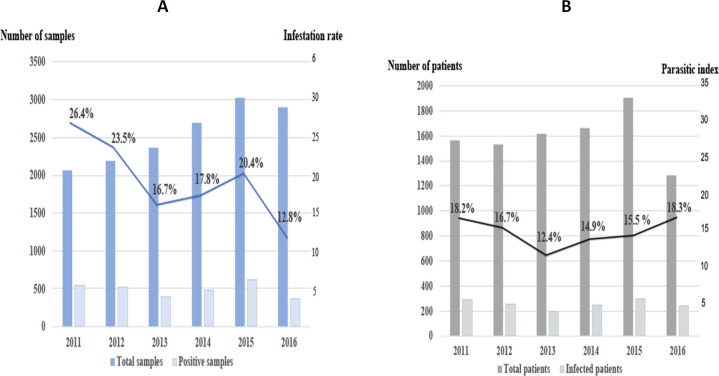
Evolution of the infestation rate (A) and the parasitic index (B) between 2011 and 2016.